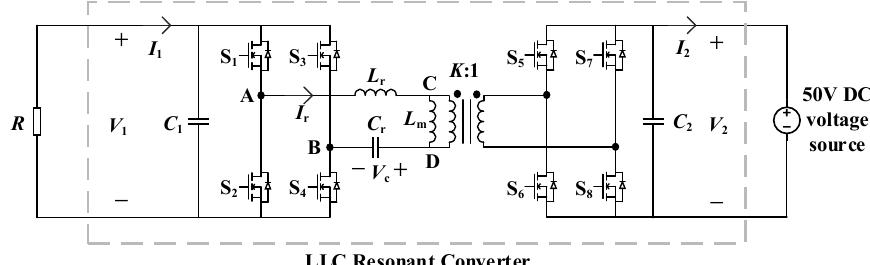
Figure 6. Structural diagram of the experimental platform.